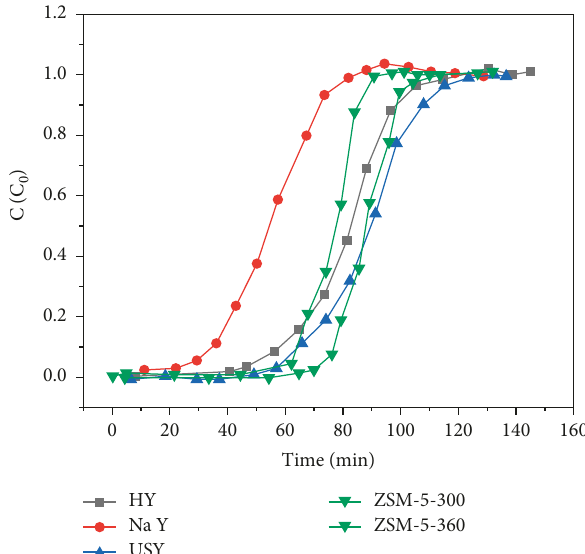
Figure 5: Adsorption breakthrough curve of ZSM-5-300 molecular sieve for mixed components of toluene, ethyl acetate, isopropanol, and acetone. Note: Airspeed 5000h − 1 . The adsorption conditions were normal pressure, (35 ± 2) ° C, molecular sieve loading 2.0g, four VOCs concentrations were 125mg/m 3 , and water vapor RH � 60%. Table 2: Adsorption parameters of mixed VOCs on ZSM-5-300 molecular